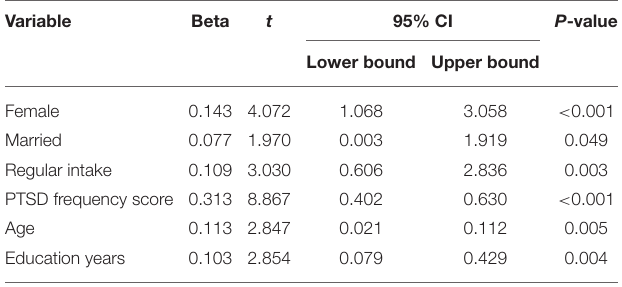
TABLE 2 | Multiple linear regression for possible related factors of Total SISQ score. Variable